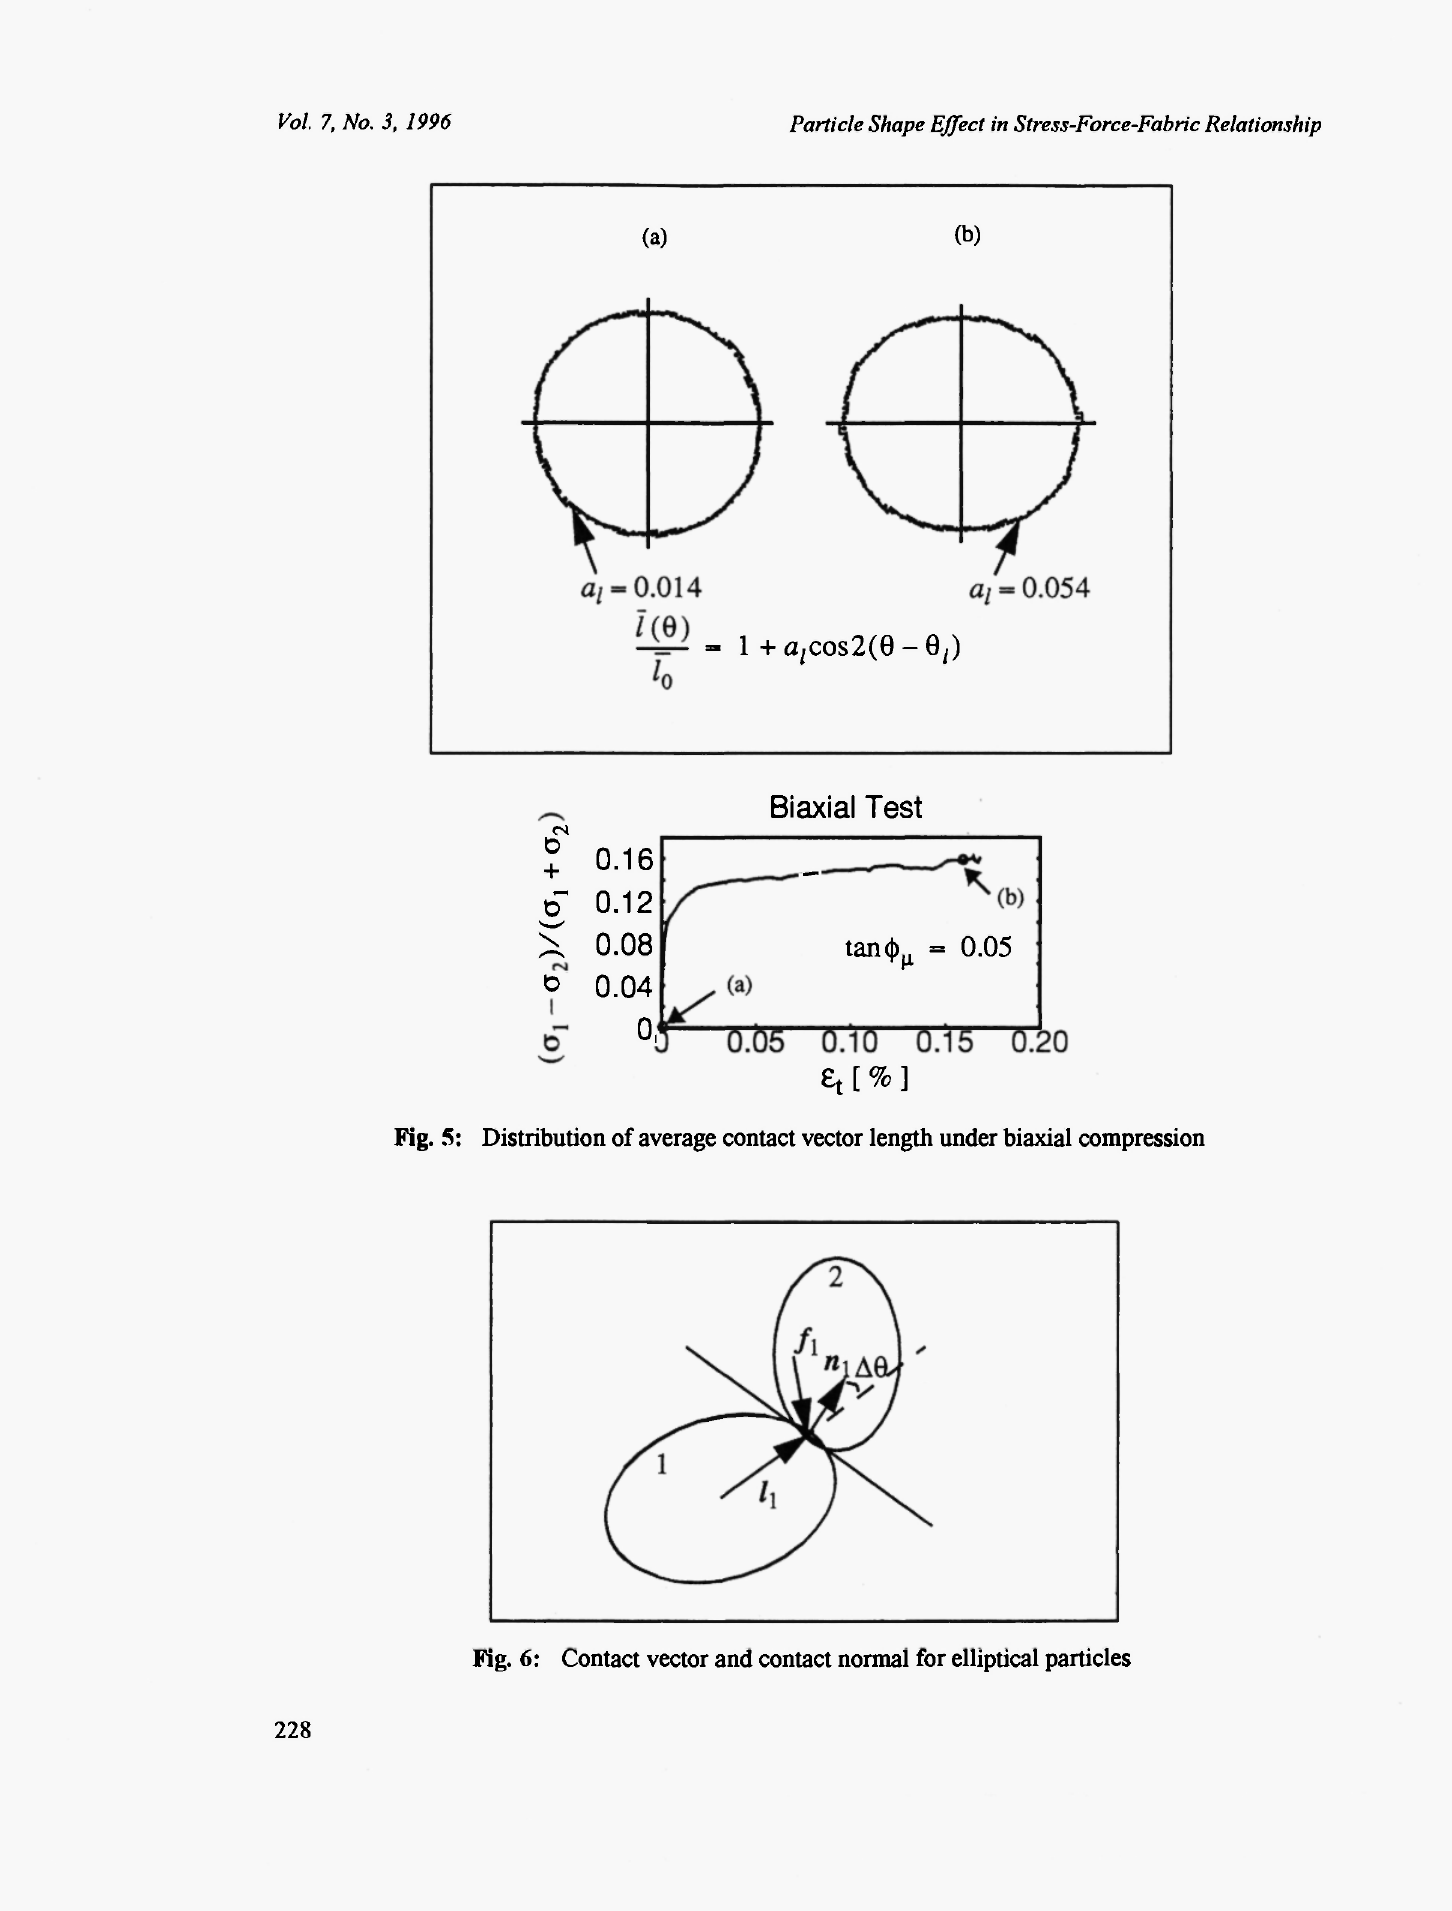
Fig. 6: Contact vector and contact normal for elliptical